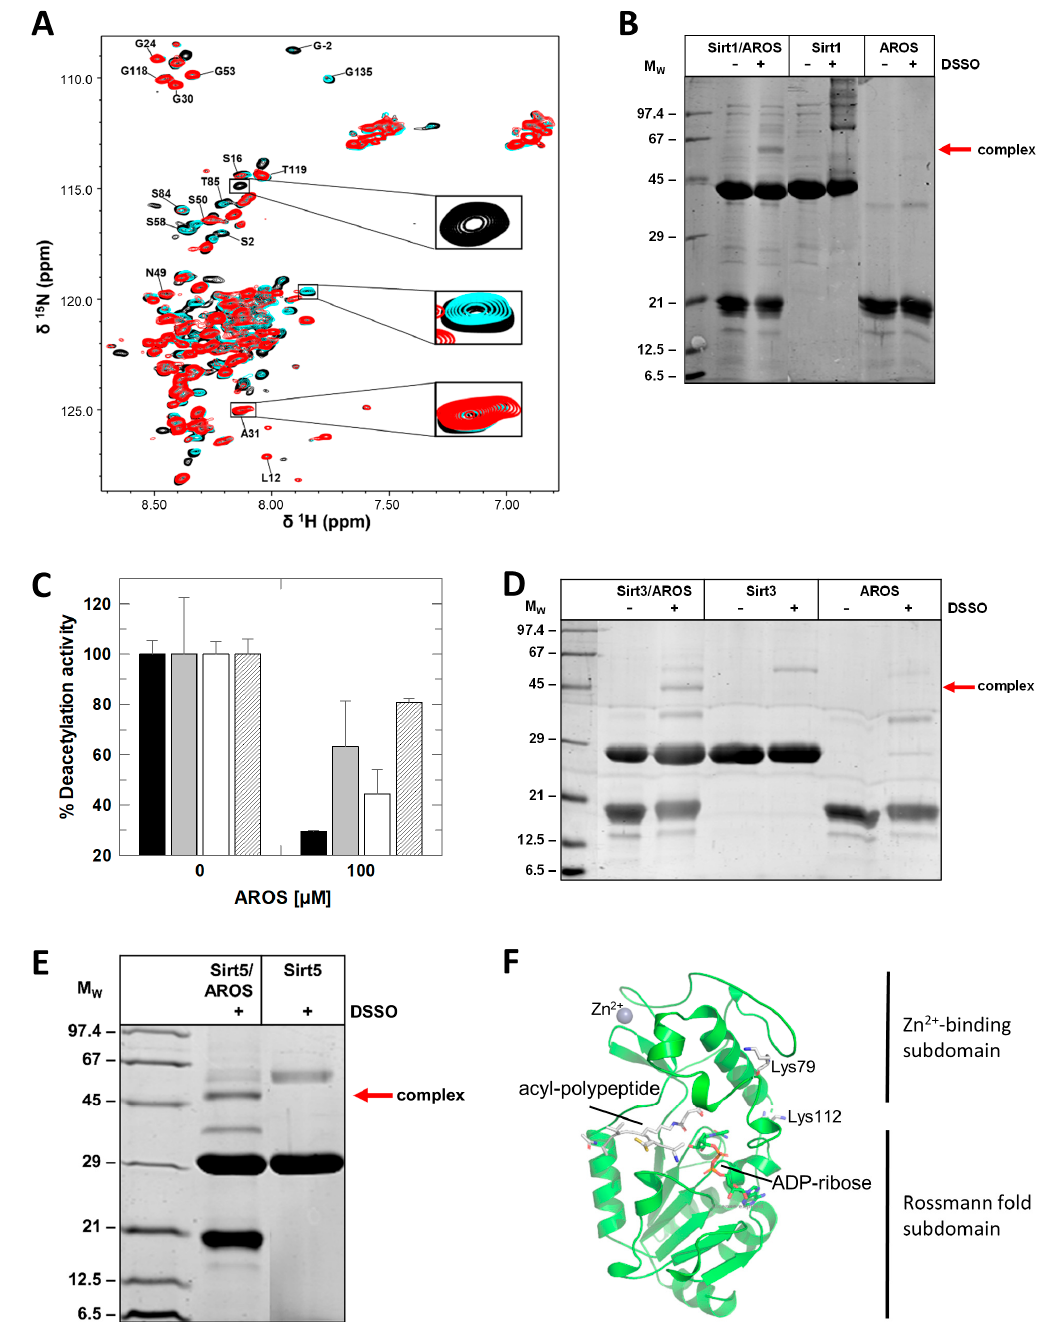
Figure 4. Mapping of the Sirt1/AROS interaction interfaces. ( A ) 2D [ 1 H, 15 N]-HSQC spectra of the titration of 150 µM 15 N-AROS with mini-Sirt1. Spectra corresponding to molar ratios 1:0, 1:0.5, and 1:1 are in black, cyan, and red, respectively. Examples of changed and unchanged signals are highlighted, and assigned signals are labeled (see Supplementary Figure S3 for mapping of changed signals on the sequence). ( B ) Crosslinking experiments with DSSO showing complex formation of Sirt1 with full-length AROS. ( C ) Effects of AROS on the deacetylase activities of mini-Sirt1 (black), Sirt2 (grey), and Sirt3 (white) and the desuccinylase activity of Sirt5 (striped). ( n = 3; error bars: SD) ( D , E ) Crosslinking experiments with DSSO showing complex formation of AROS ( D ) with Sirt3 and ( E ) with Sirt5. ( F ) Location of Sirt5 residues identified as cross-linking sites indicated as sticks and labeled. The figure was generated from the crystal structure of a Sirt5 complex with substrate peptide and NAD + analog (PDB ID 4G1C) [28].